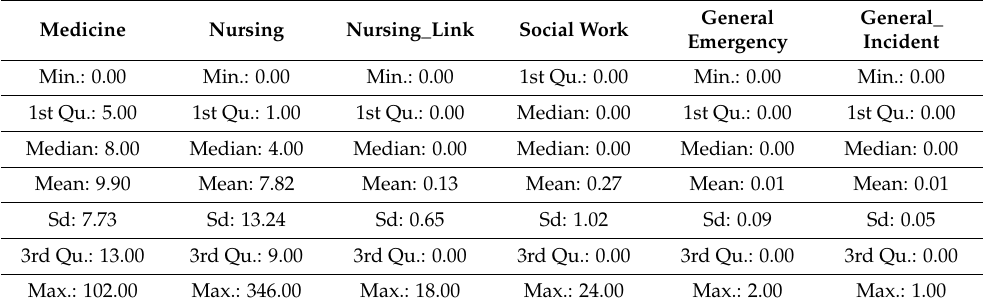
Table 4. Consultations made in primary care for people over 65 years of age who live alone, based on different specialties. Basic Health Areas of Gran Canaria. 2018–2020. Descriptive.